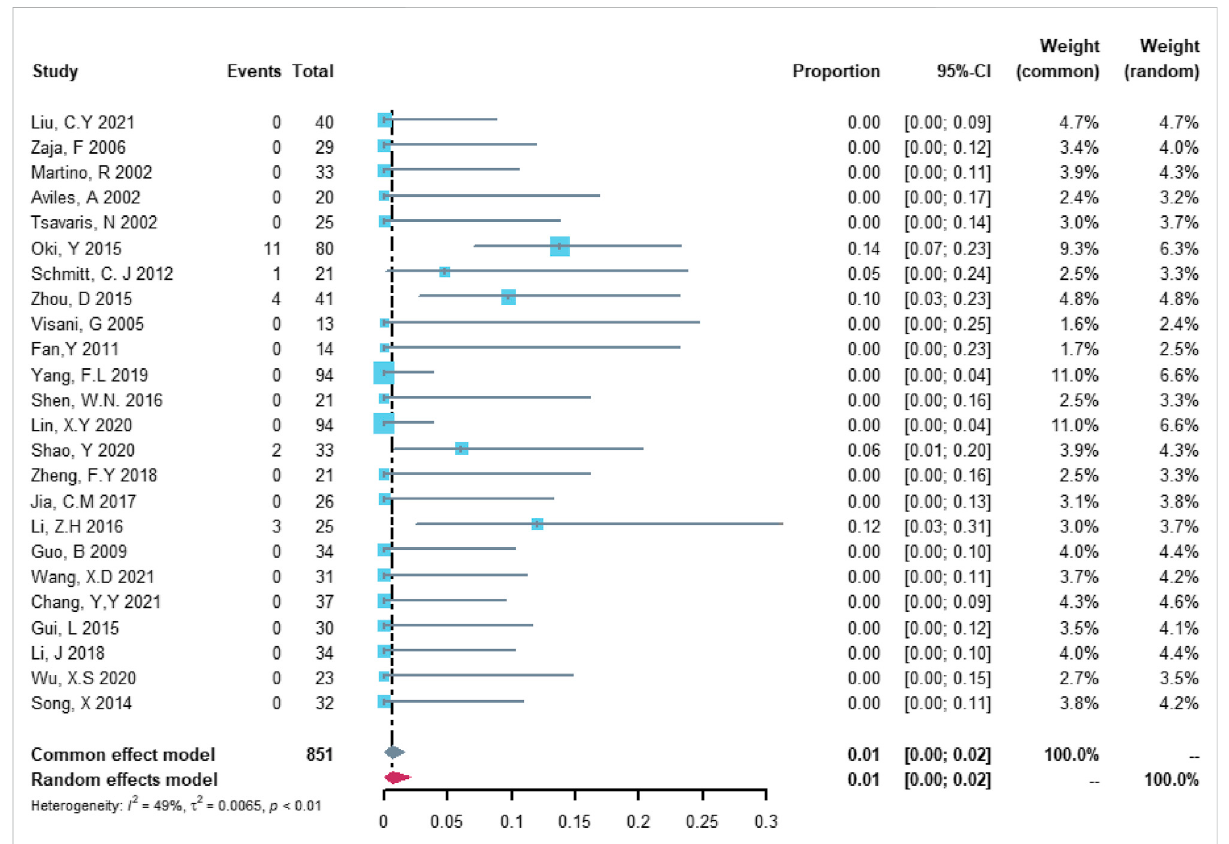
FIGURE 4 Summary pooled proportion analysis of serious cardiovascular adverse events associated with the (R)-CDOP combination